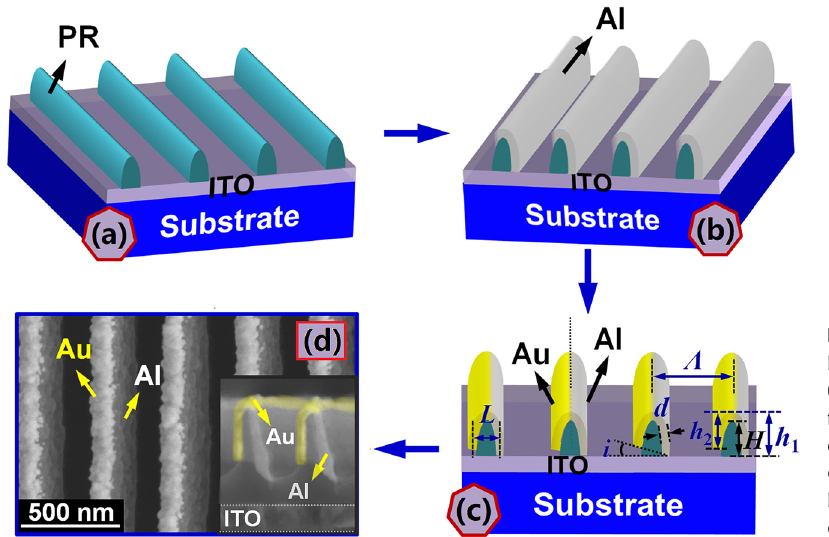
Figure 2: Fabrication procedure of Au – Al bimetallic